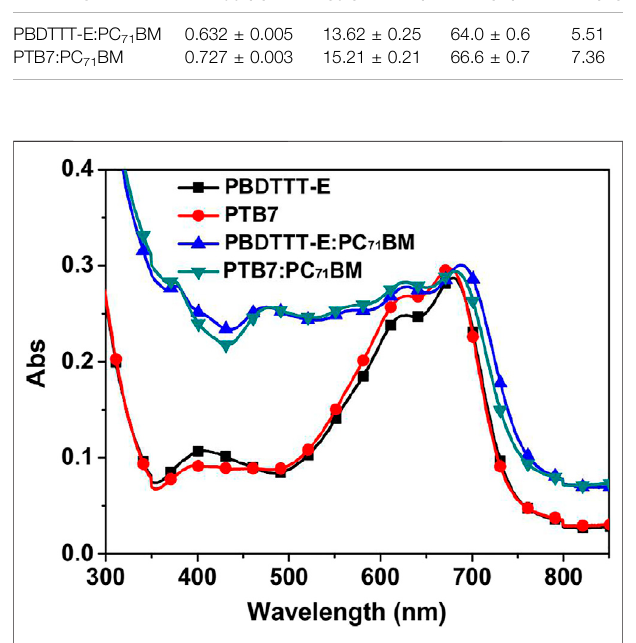
FIGURE 3 | Absorption spectra of PBDTTT-E, PTB7, PBDTTT-E: PC 71 BM, and PTB7:PC 71 BM active